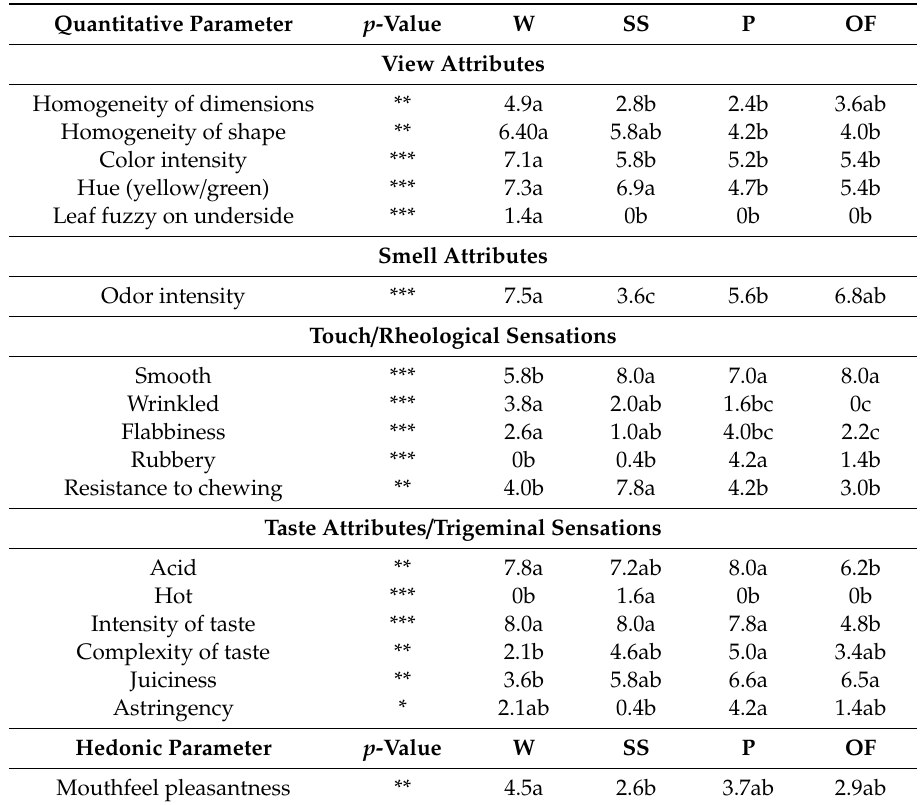
Table 1. Two-way ANOVA calculated for all quantitative and hedonic parameters evaluated by panelists during tasting sessions for Rumex acetosa . Only data that showed significant di ff erences ( p < 0.05) are reported. Means keyed with a di ff erent letter are significantly di ff erent for p = 0.05, considering each species independently and following one-way ANOVA, with wild-collection or the di ff erent domestications as the variability factor. Significance level: ***: p < 0.001 (F = 7.94); **: p < 0.01 (F = 4.77); *: p < 0.05 (F =